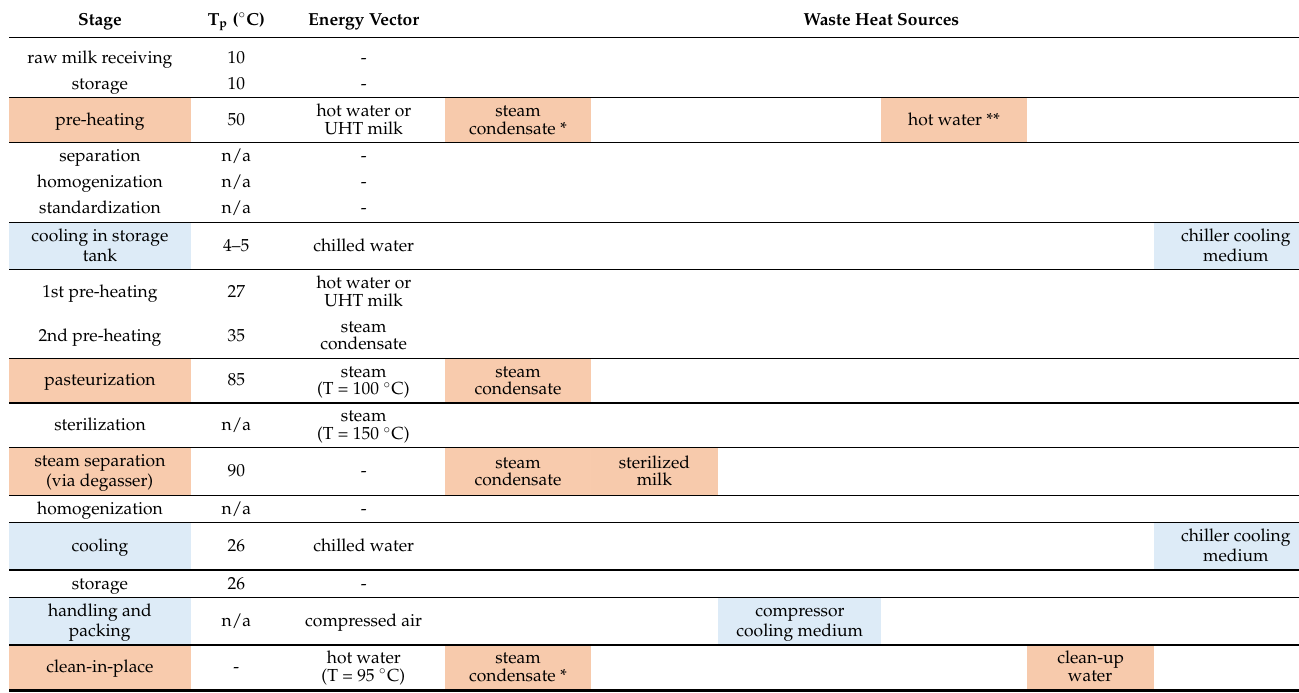
Table A1. Scheme of UHT milk manufacturing process and corresponding low-temperature waste heat